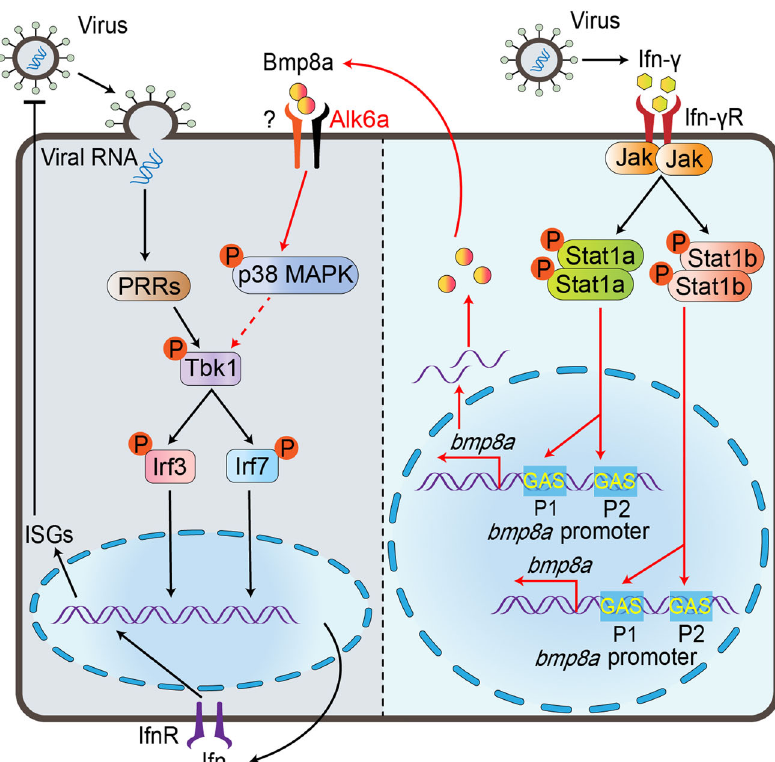
Fig. 9 Schematic illustration of Bmp8a serving as positive regulator in the antiviral immune. Upon virus infection, the transcriptions of bmp8a are activated through the Jak-Stat1 pathway. The Bmp8a binds to BMP type I receptor Alk6a, promoting phosphorylation of Tbk1 and Irf3 to induce the expression of Ifn through p38 MAPK